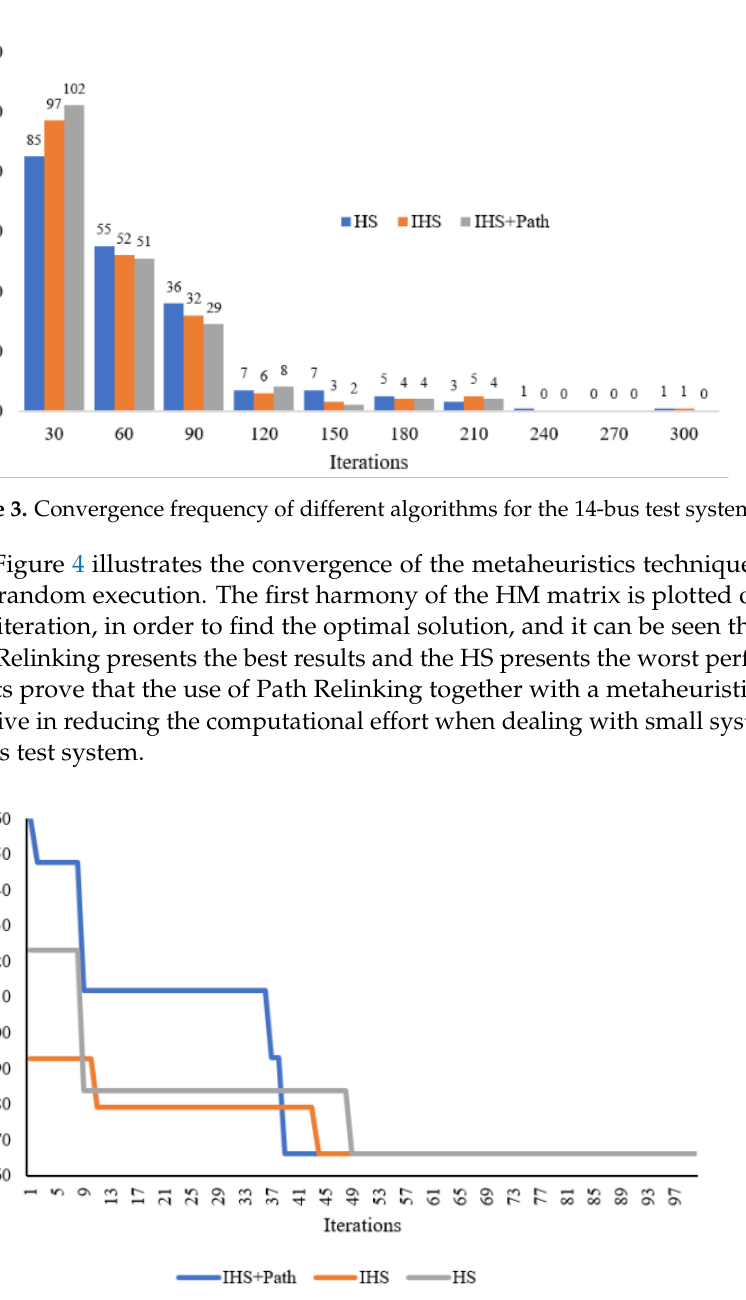
Figure 4. Convergence of the algorithms implemented for the 14-bus test system.